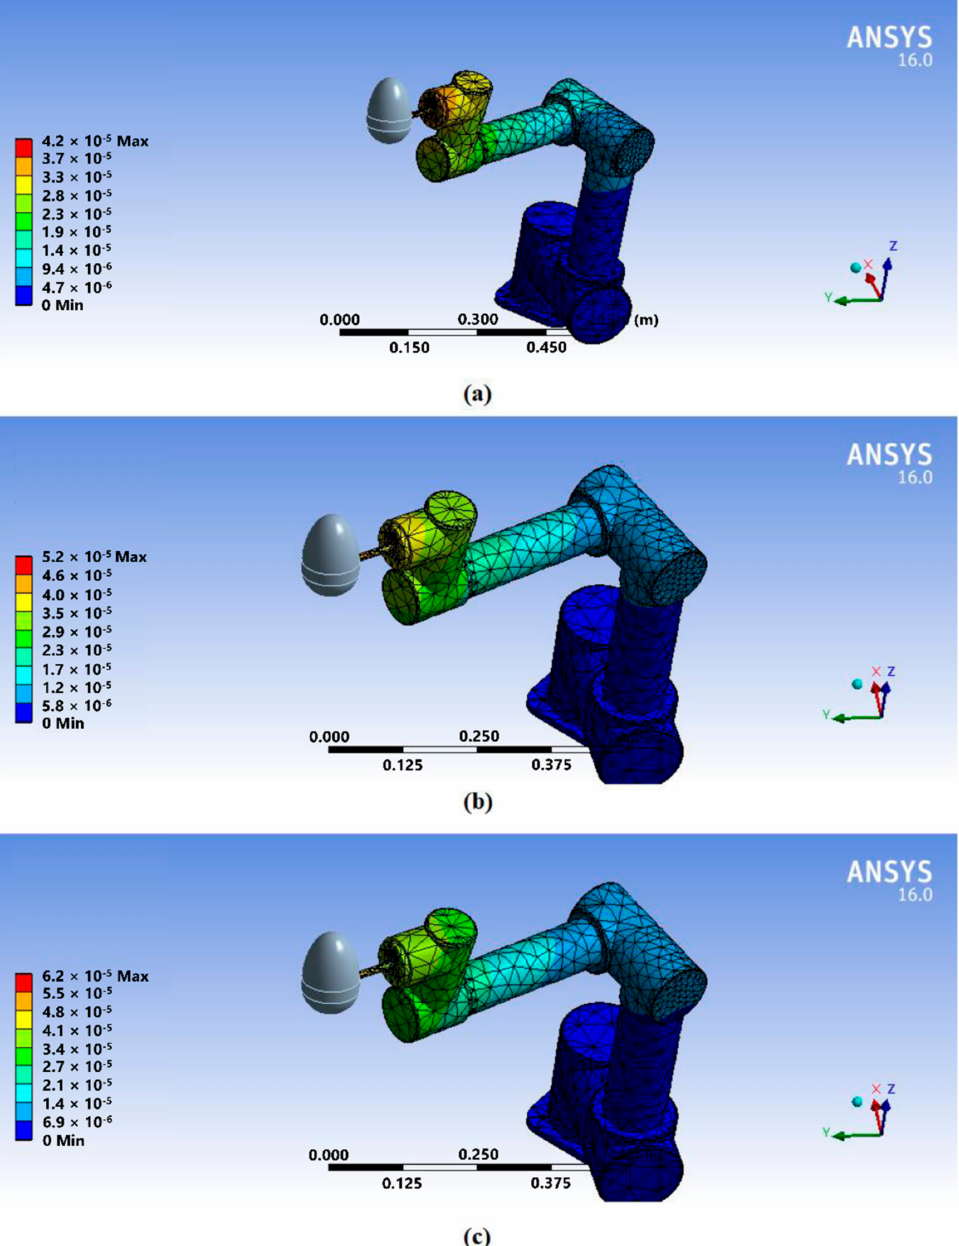
Figure 4. Deformation of the manipulator under different loads in the Z direction: ( a ) 0 N, ( b ) 10 N, and ( c ) 20